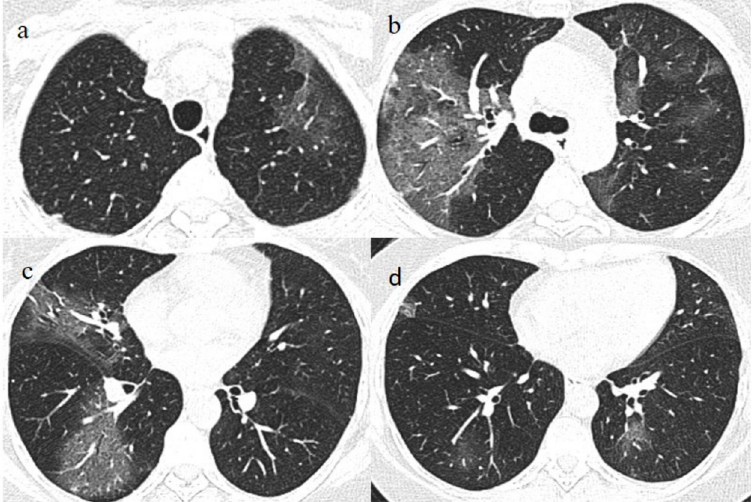
Figure 5. Chest CT performed in the emergency room on 1 July. ( a ) Some GGO in the left superior lobe, ( b ) in the right superior lobe, ( c ) the middle and right lobe, and ( d ) the inferior lobes.